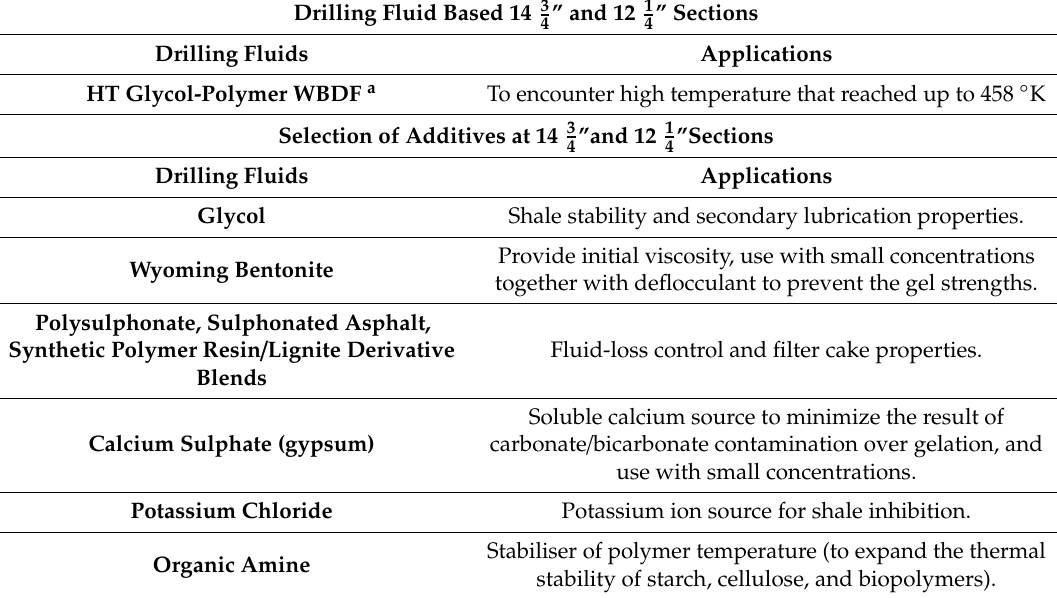
Table 9. Drilling fluid and its applications in 14 3